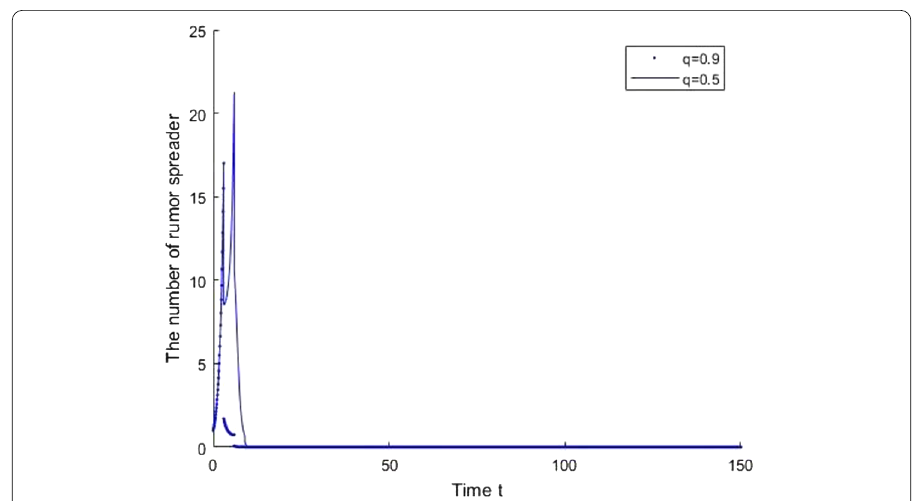
Figure 8 When q > q thr , the evolution graph with different q of x ( t ) both tend to 0